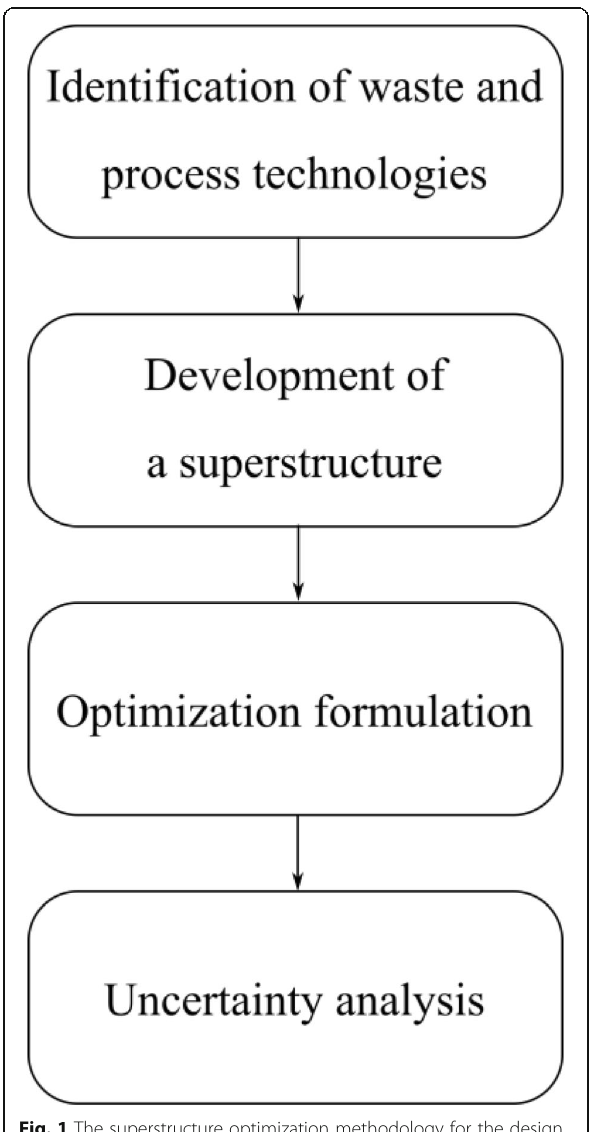
Fig. 1 The superstructure optimization methodology for the design of an optimal